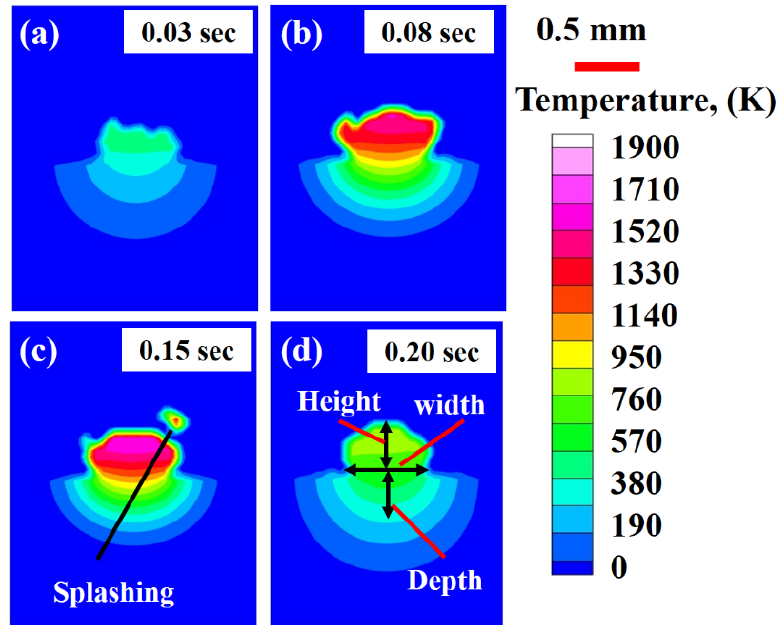
Figure 6. Thermal distribution at laser beam location in the Ti6Al4V cross section deposited by LMD at: ( a ) 0.03 s, ( b ) 0.08 s, ( c ) 0.15 s and ( d ) 0.20 s.